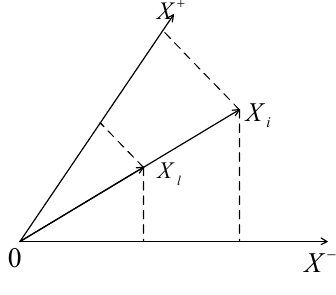
Figure 2. The closeness degree of projection model.